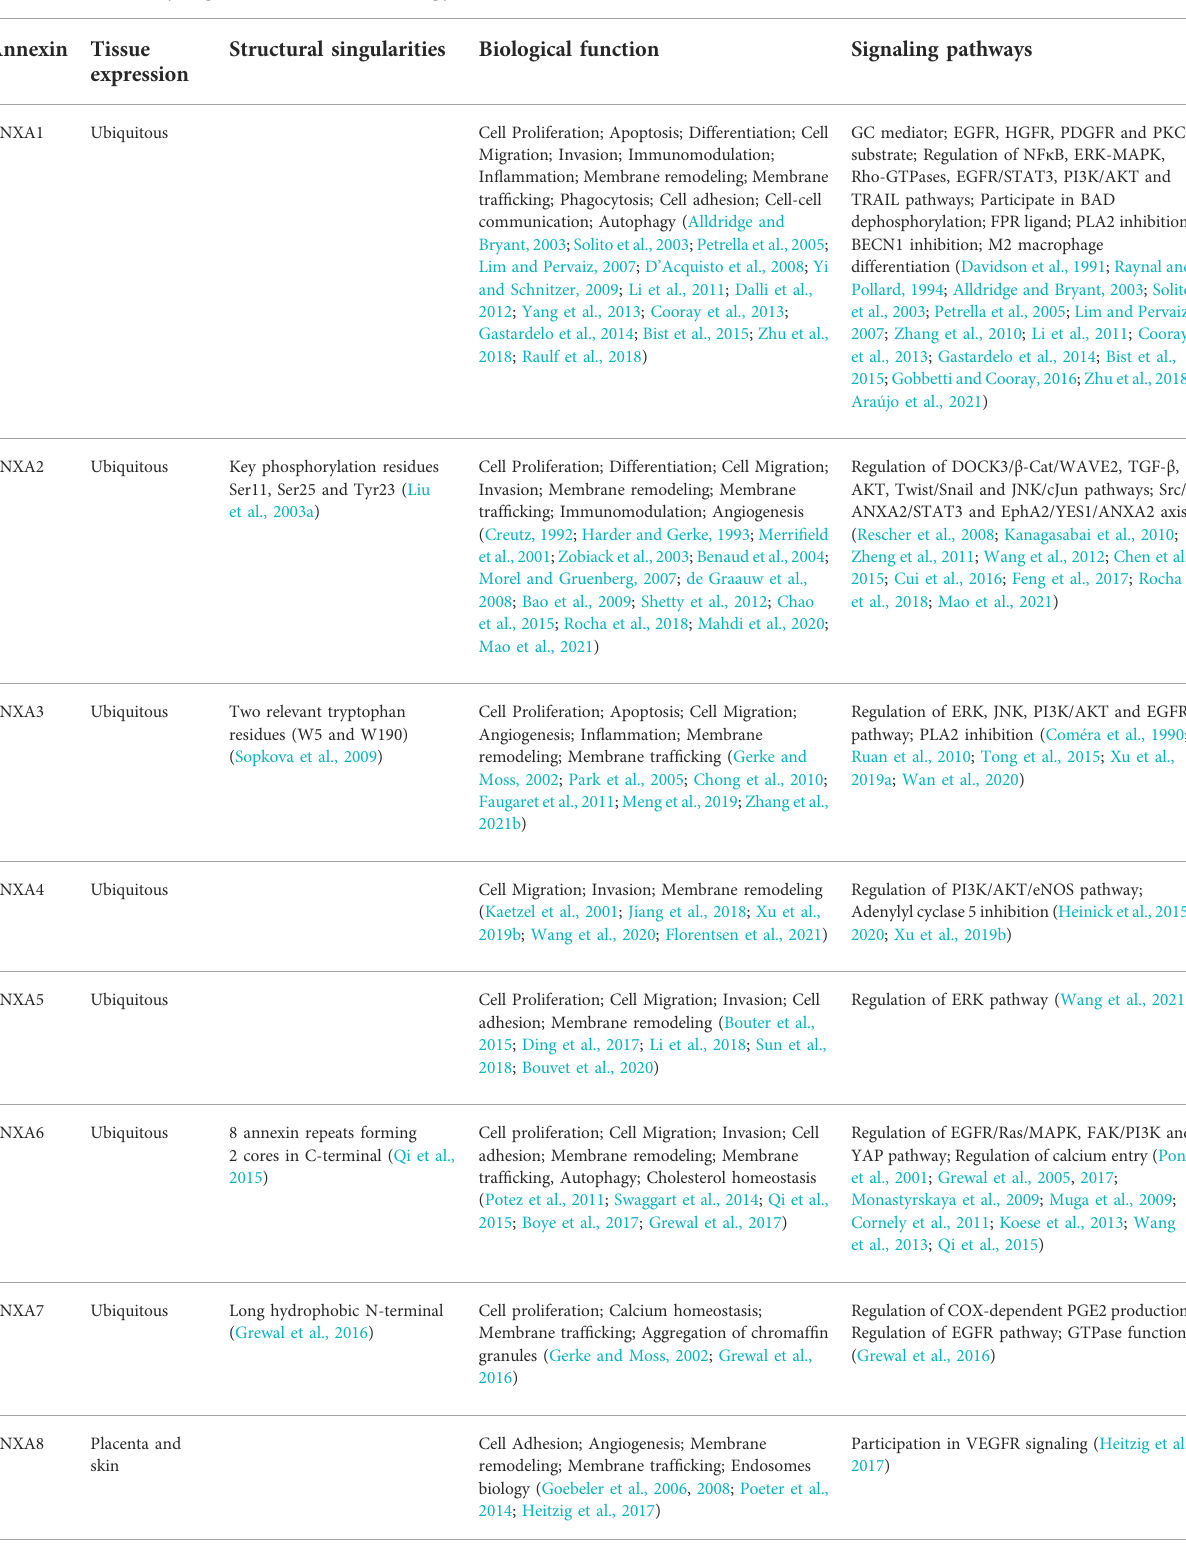
TABLE 2 Functional and mechanistic roles of annexin dysregulation in cancer